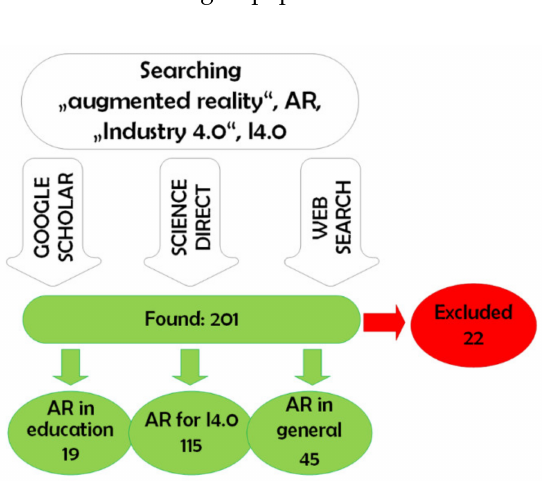
Figure 3. Search results for AR and I4.0 publications in online